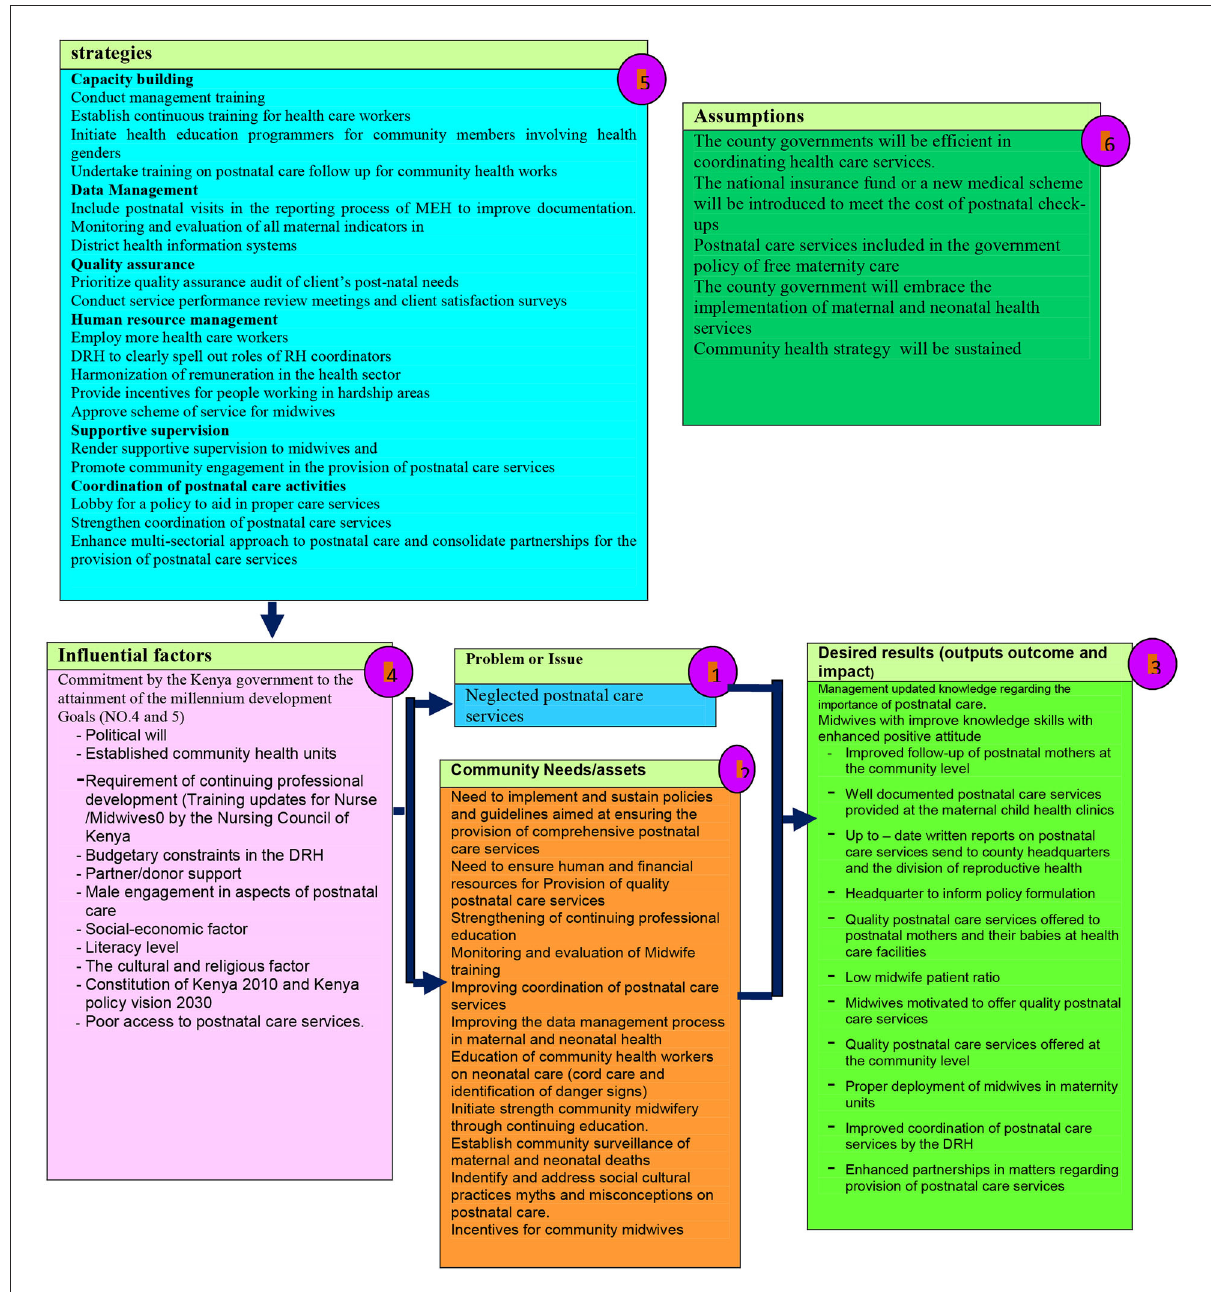
FIGURE1 Framework for improving postnatal care utilization [Chelagat